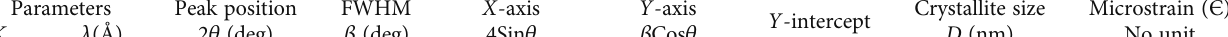
Table 1: The estimation of crystallite size and microstrain in pure and Mn-doped ZnO samples using the W-H method. Parameters Peak position FWHM X -axis Y -axis Y K Structural parameters for pure ZnO XRD ’ s data using Williamson-Hall plot 0.94 1.5406